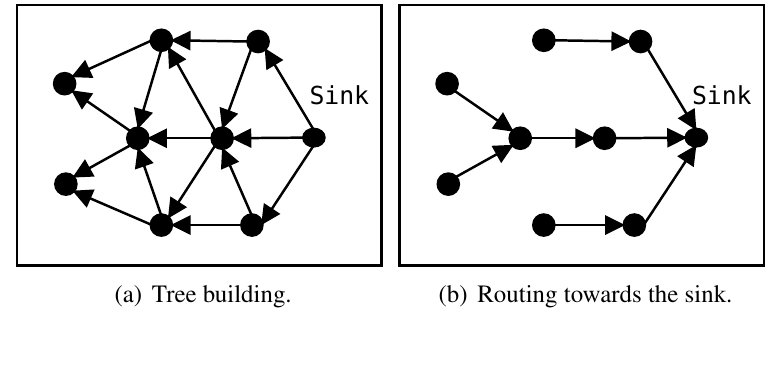
Figure 2. EF-Tree